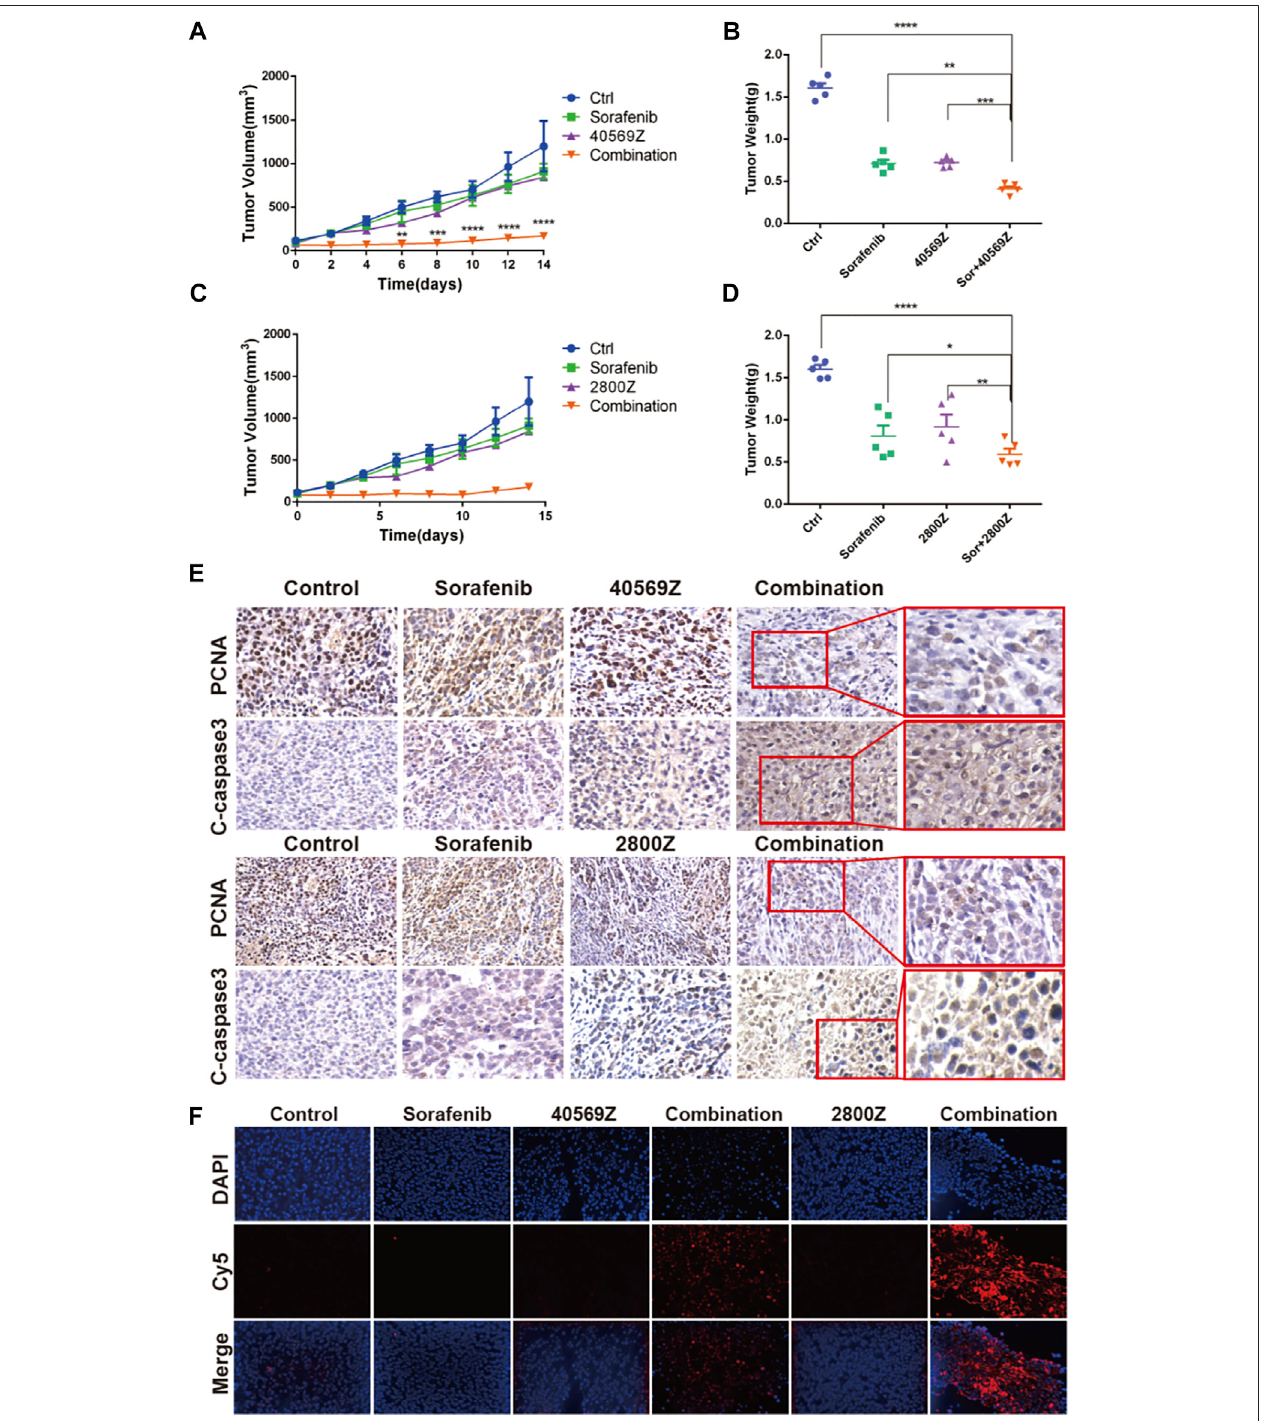
FIGURE 6 | In vivo assessment of anticancer effects of 2800Z and 40569Z. (A) Tumor growth curves of tumor bearing nude mice that received vehicle, 2800Z (4 mg/kg),40569Z(3 mg/kg)orsorafenib(3 mg/kg)treatmentfor2 weeks.Graphsshowmean ± SEM.**** p < 0.0001VSsorafenib,one-wayANOVA. (B) Tumorweight after treatment as in A. Graphs show mean ± SEM. *** p < 0.001, **** p < 0.0001, VS control, one-way ANOVA. (C) Tumor growth curves of tumor that received vehicle, 2800Z (2 mg/kg), 40569Z (1 mg/kg), sorafenib (2 mg/kg), or combination (2800Z or 40569Z and sorafenib) treatment for 2weeks. Graphs show mean ± SEM. **** p < 0.0001, VScontrol, one-way ANOVA. (D) Differences in tumor weight.Graphsshow mean ± SEM.* p < 0.05, ** p < 0.01, **** p < 0.0001. All graphsshow mean ± SEM of at least three independent experiments. Control, one-way ANOVA. (E, F) Representative IHC staining of PCNA and cleaved-caspase3 (C-caspase) (E) and TUNEL staining (F) in tumors as in B and D.